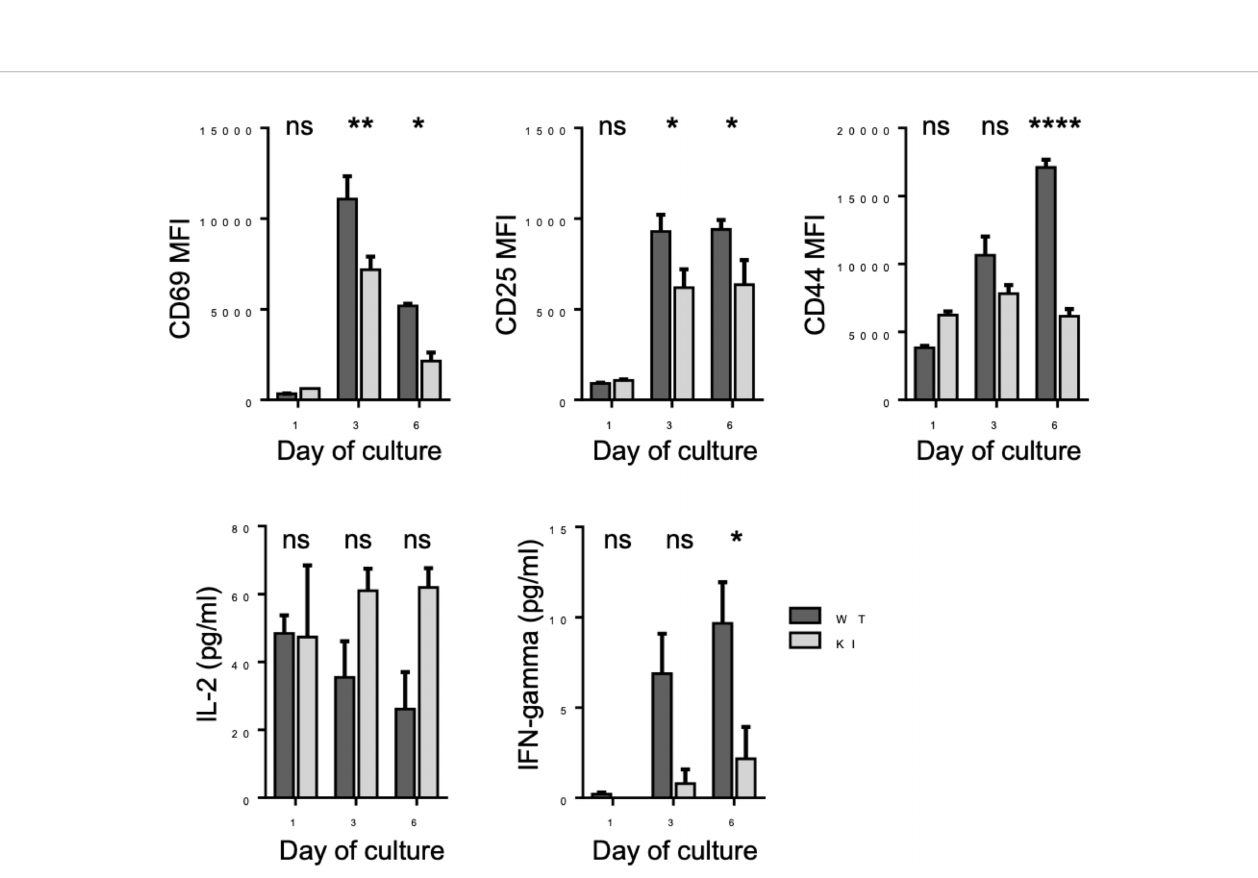
FIGURE 5 | Activation of WT and KI CD8+ T cells following stimulation with anti-CD3 stimulatory antibodies for 1-6 days in vitro . Pooled data from 2 independent experiments, each with 2 biological replicates (donor mice). *p < 0.05; **p < 0.01; ****p < 0.0001; ns, non signi fi